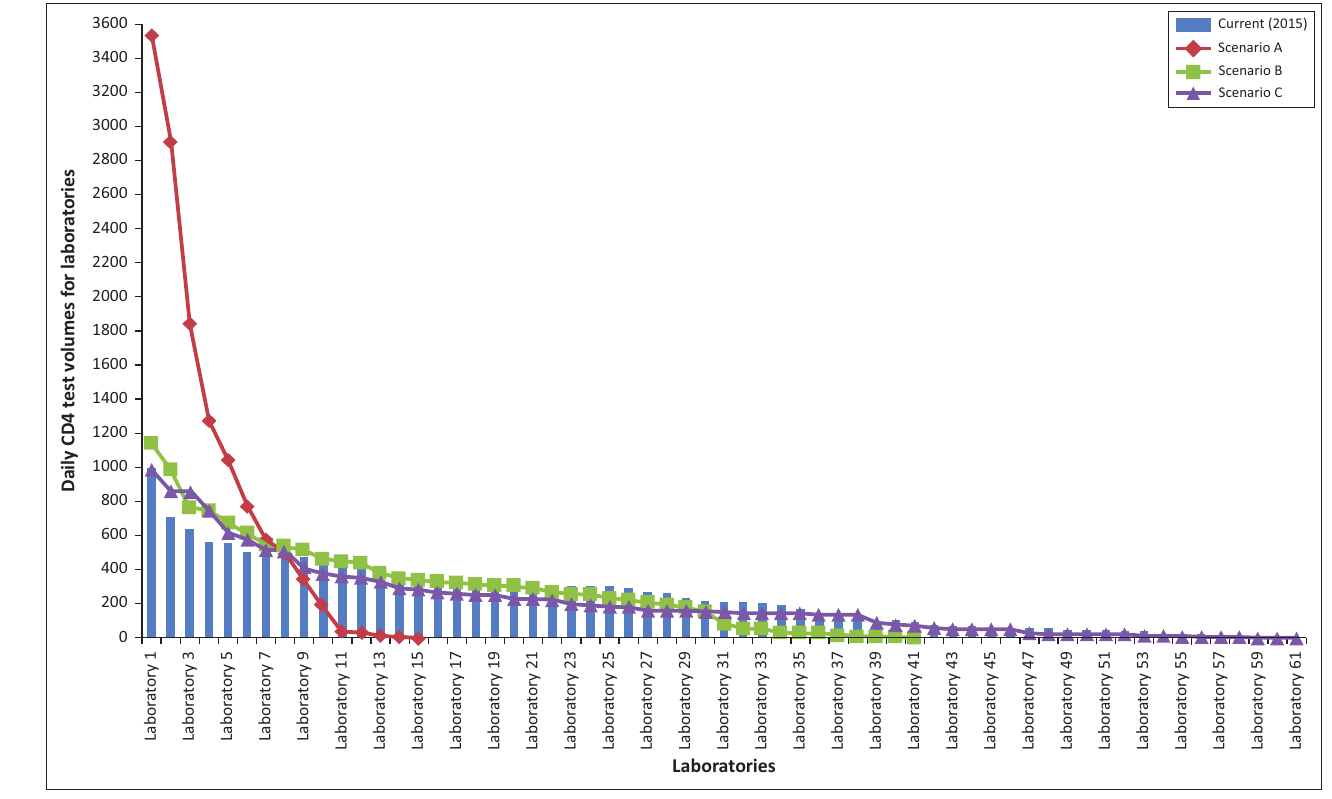
FIGURE 4: Daily laboratory test volumes for scenarios A, B and C compared to current 2015 TABLE 2: Daily laboratory volumes for the 10 busiest laboratories for scenarios A, B and C with the platform, space requirements and percentage increase in volumes compared to 2015 volumes.